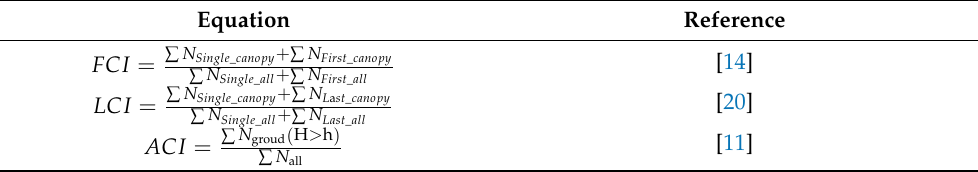
Table 2. LiDAR cover